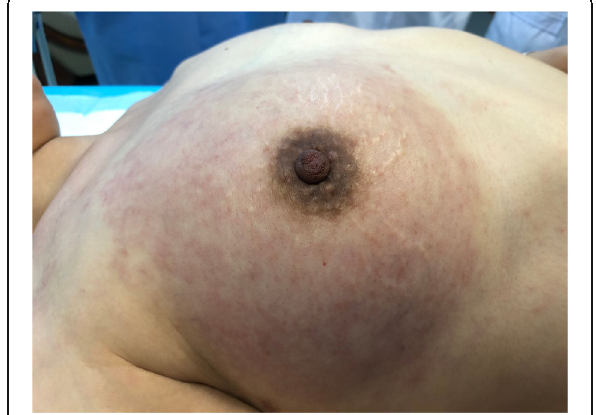
Fig. 3 Ipsilateral Breast Metastasis. The right breast with whole redness looked like an inflammatory breast cancer ten months after the surgical resection of the right axillary lymph nodes and right supraclavicular lymph nodes